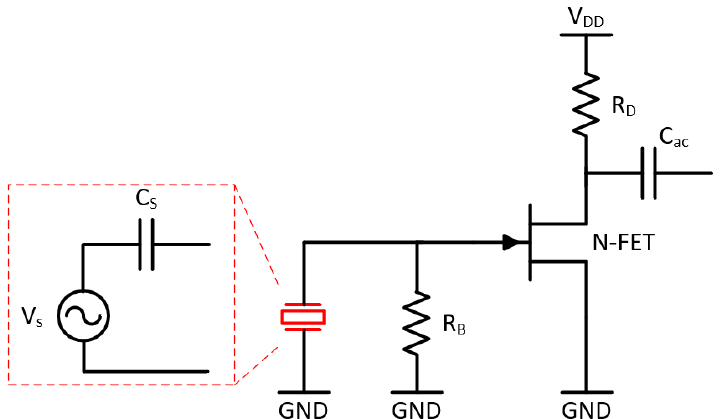
Figure 1. Electronic circuit (impedance converter) interfacing with the high-impedance sound sensor. The piezoelectric sensor (in red) is modelled as a voltage source in series with a capacitance in its linear mode (highlighted with red-dashed lines).